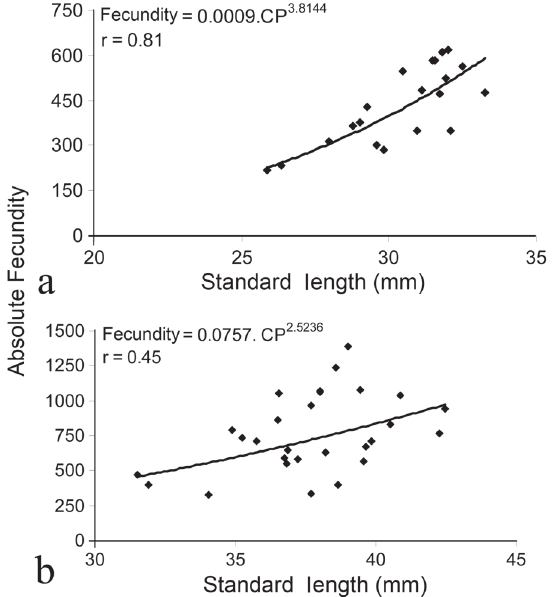
Fig. 7. Relation between absolute fecundity and standard length of females of Compsura heterura ( a ), from rio Ceará- Mirim, RN, and of Odontostilbe pequira ( b ) from rio Ibicuí- Mirim, RS.